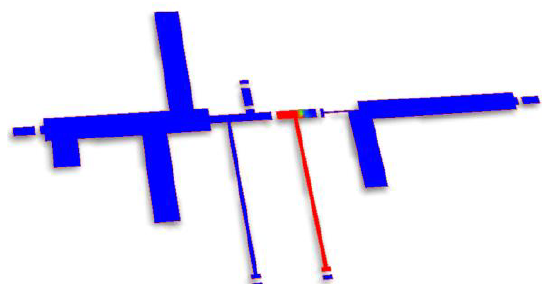
Fig. 22. EM-circuit excitation result @ 0 GHz (DC point)